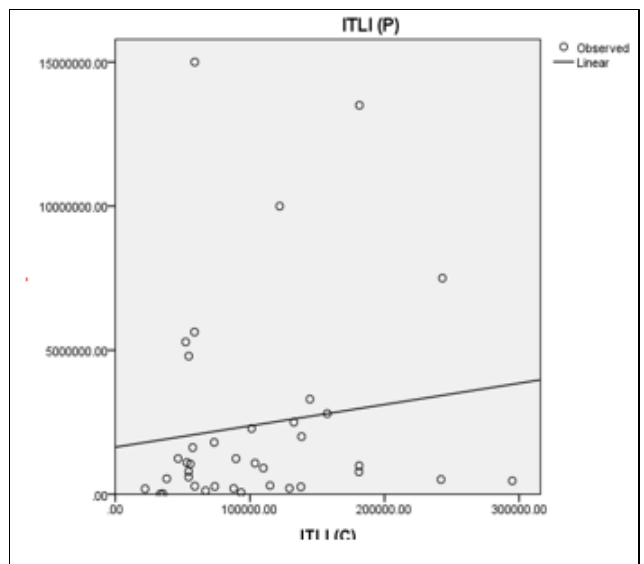
Figure 5a: The linear regression diagrams of cost/revenue analysis of industrial